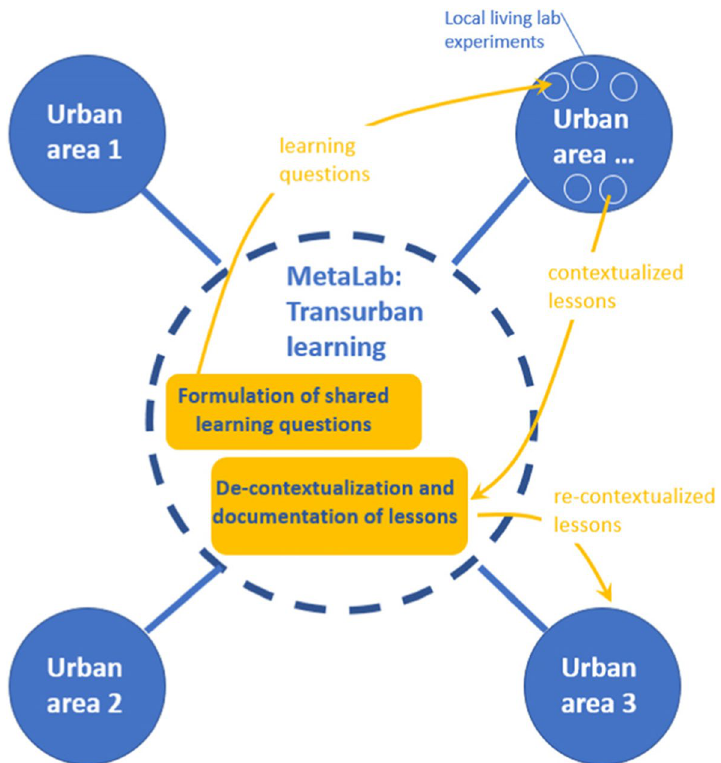
Fig. 2 The learning activities part of the meta-lab